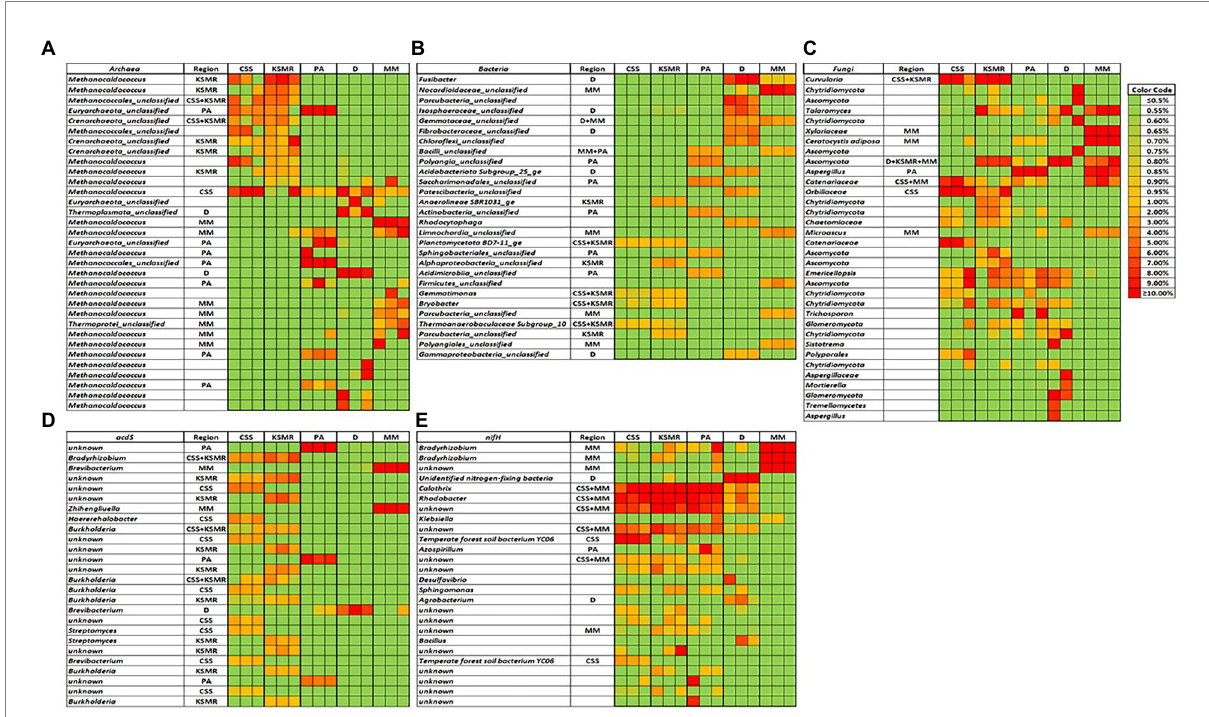
FIGURE 4 Heat maps showing the dominant soil archaeal (A) , bacterial (B) , and fungal (C) , phylotypes, and bacteria with acdS (D) , and nifH genes (E) , in five soils collected from agricultural fields in the Indus River Basin, Pakistan, and whether they can be considered as indicator species for a particular region. CCS, Choa Saidan Shah; KSMR, Khewra salt mines range; PA, Pakka Anna; D, Daharki; MM, Mirpur